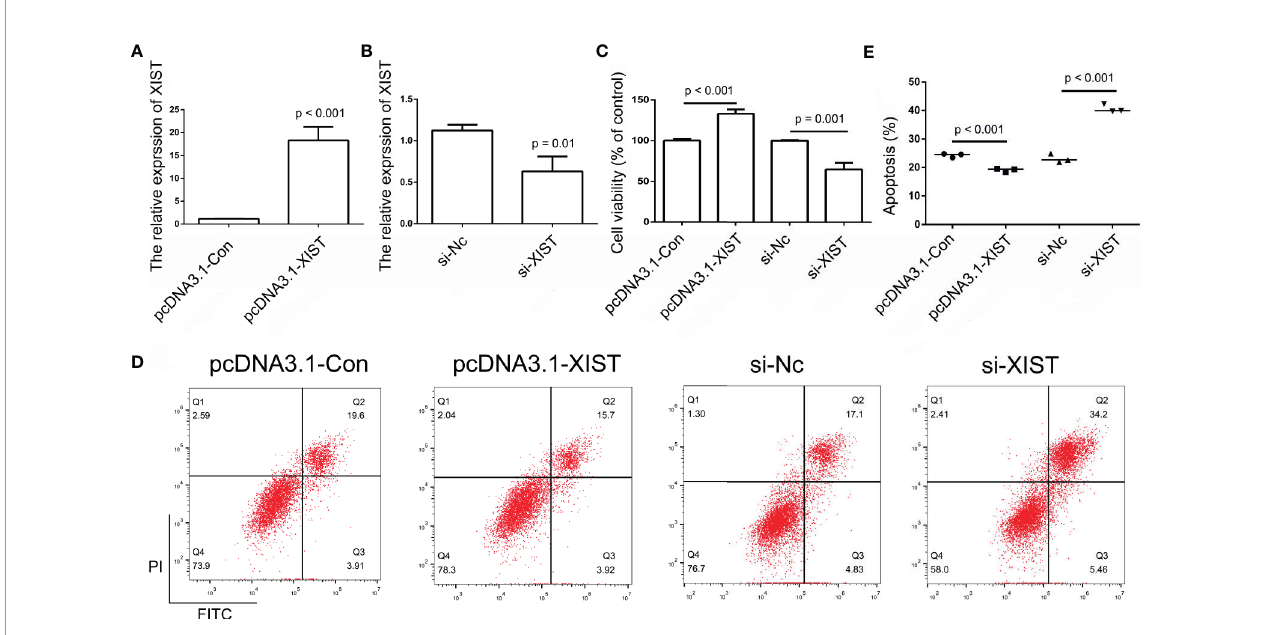
FIGURE 4 | Analysis of XIST expression. (A, B) Relative expression of XIST in pcDNA3.1-Con, pcDNA3.1-XIST, si-Nc, and si-XIST groups, respectively, using qPCR in SCC9 cells. Data are represented as mean ± SD (n = 3). (C) Cell growth was analyzed using the CCK-8 assay in SCC9 cells to determine the effect of XIST on cell proliferation. (D) Cell apoptosis was analyzed after transfection with pcDNA3.1-XIST and si-XIST in SCC9 cells to determine the effect of XIST on cell apoptosis. (E) Statistical analysis of the percentage of cells undergoing apoptosis in the four groups. Statistical signi fi cances between groups were evaluated using t-test for independent groups.